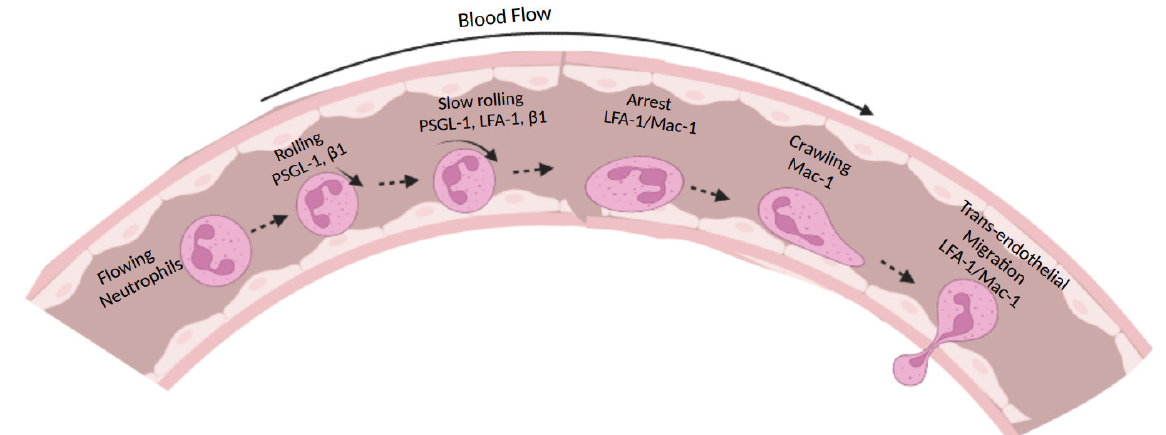
Figure 1. Schematic of neutrophil recruitment cascade: Flowing neutrophils roll on vascular endothelial cells through the interaction between PSGL-1 and selectins. Engagement of PSGL-1 with selectins induces the extension of LFA-1, which binds ICAM-1 or other ligands with an intermediate affinity and slows down rolling velocity. We call this process slow rolling. β 1 Integrins are also involved in neutrophil rolling and slow rolling. When rolling neutrophils encounter chemokines, LFA-1 or Mac-1 will be fully activated and bind ICAM-1 or other ligands with a high affinity and stop rolling neutrophils. We call this process arrest. After arrest, neutrophils spread and crawl on endothelial cells, which is predominantly mediated by Mac-1. Neutrophils undergo trans-endothelial migration in an LFA-1/Mac-1-dependent manner to the tissue or site of injury. Created in BioRender.com (accessed on 12 June 2022).